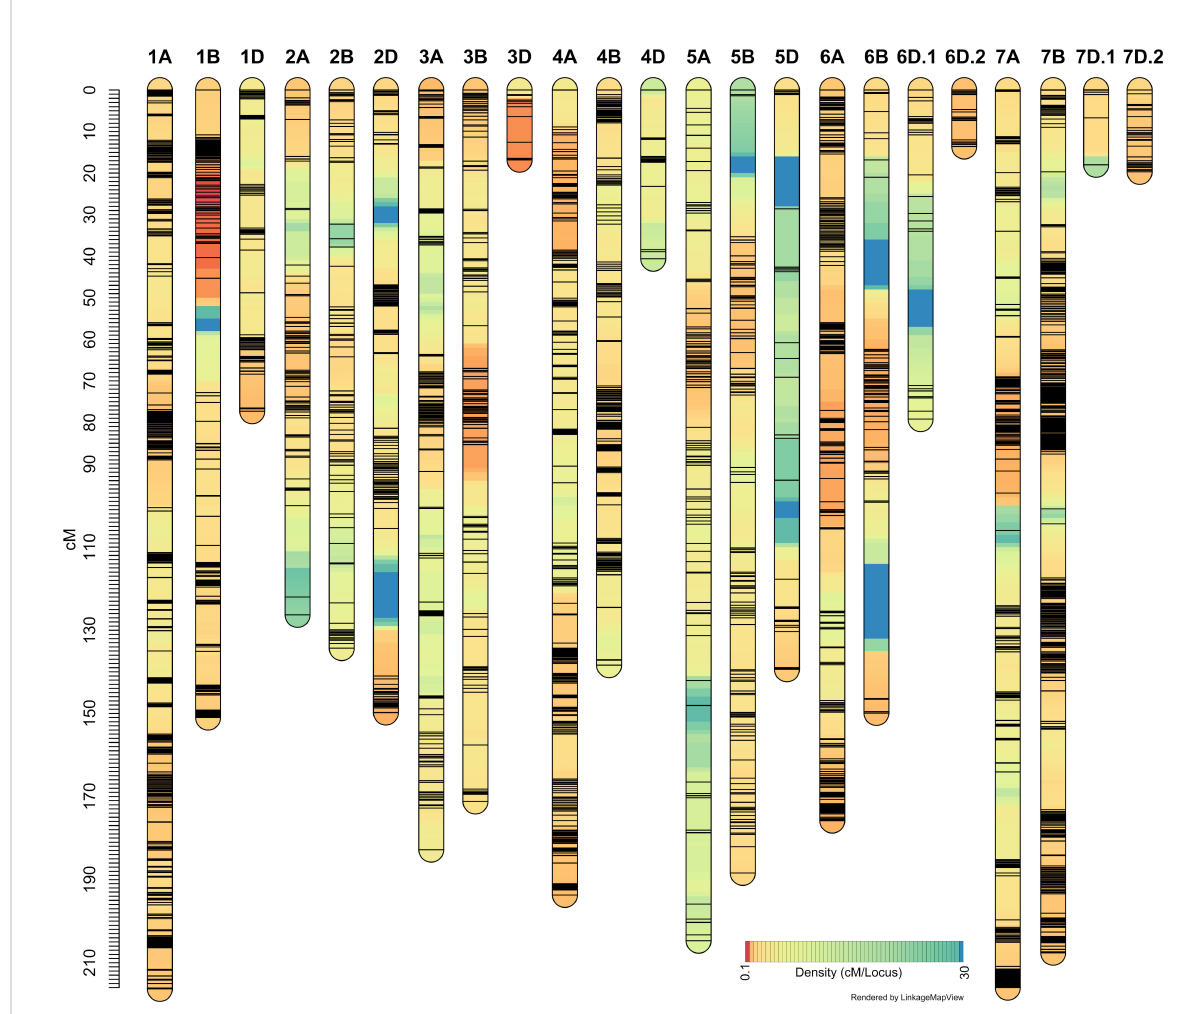
FIGURE 5 ‘ AAC Innova/P2711 ’ linkage map constructed using single nucleotide polymorphism (SNP) markers from 90K wheat SNP